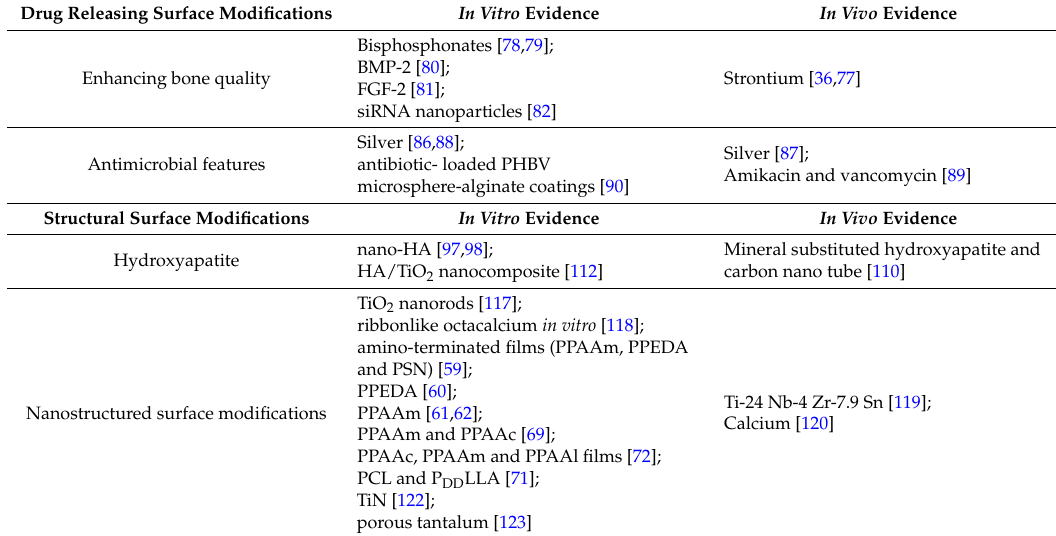
Table 1. Biological